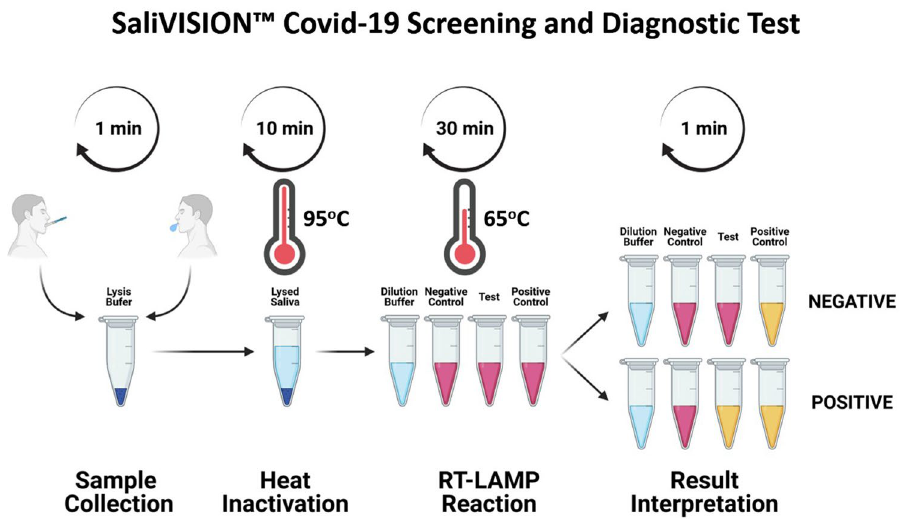
Figure 6. SaliVISION Covid-19 Screening and Diagnostic Approach. (1) The saliva sample self-collected with passive drooling or with MicroSAL Saliva Collection Kit is placed in a Collection Tube pre-loaded with Lysis Buffer; (2) The collected saliva sample in the Collection Tube is lysed and heat-inactivated at 95 °C in 10 min; (3) A fixed volume of inactivated saliva is processed through a serial dilution step in a microtube test strip pre- loaded with Dilution Buffer (#0), negative control (#1), SARS-CoV-2 test with multiplex primers targeting the viral N gene (#2), and internal control with human RNP gene (#3). The RT-PCR reaction will be processed at 65 °C for 30 min; (4) The result is read and interpreted with the cooled reaction mixes after a 30-min incubation with a REPORT